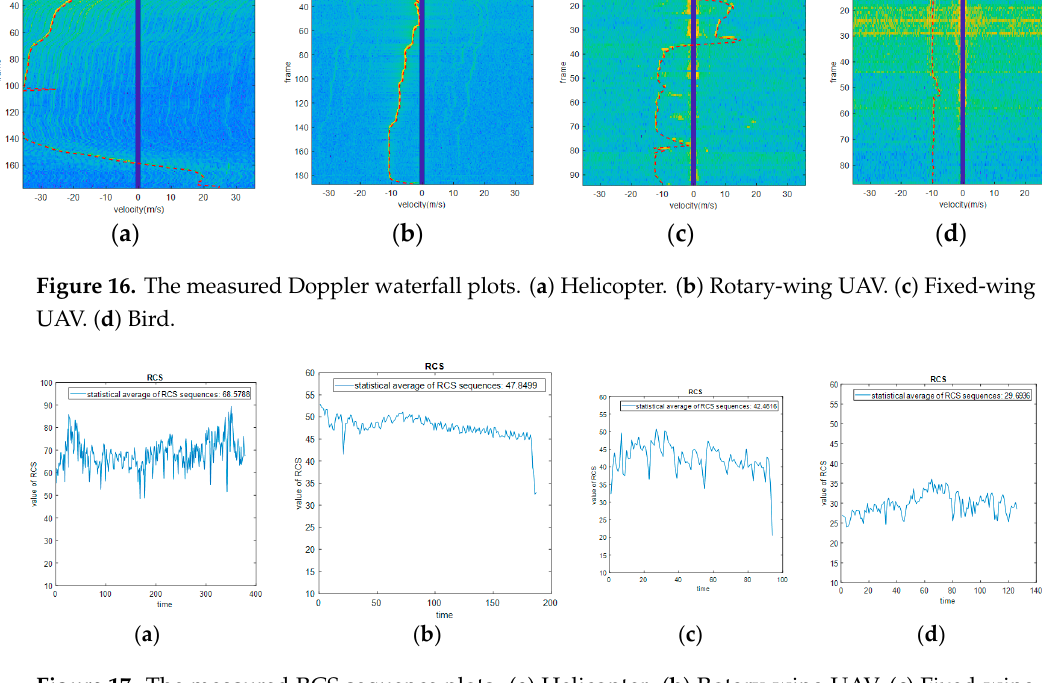
Figure 17. The measured RCS sequence plots. ( a ) Helicopter. ( b ) Rotary-wing UAV. ( c ) Fixed-wing UAV. ( d ) Bird.